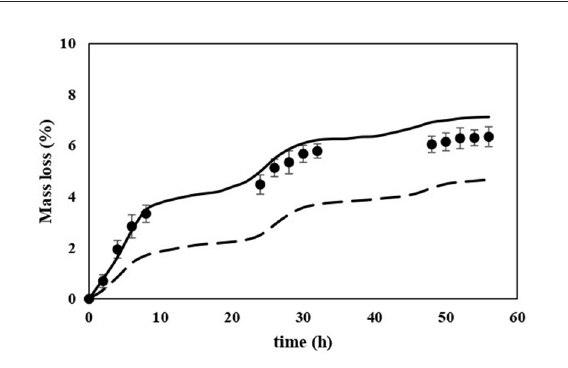
FIGURE10 Predicted mass loss of the whole onion bulbs cured for a total duration of 3 days in comparison with experimental data. Solid and broken lines represent predicted mass loss with and without taking into account mass loss from the neck, respectively. Symbols represent measured mass loss (error bars are standard errors, n = 5).